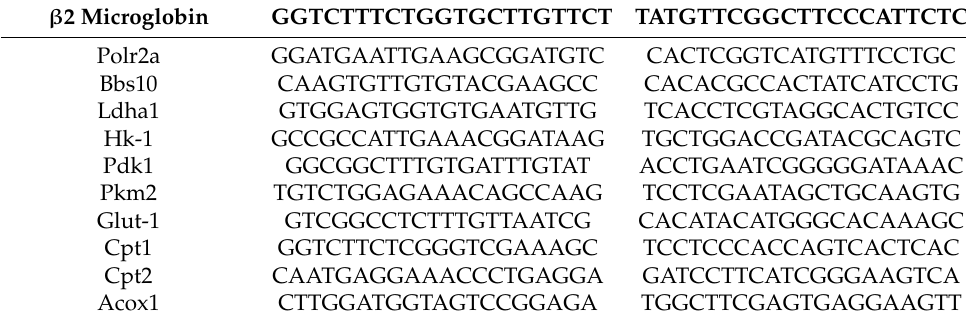
Table 5. The primer